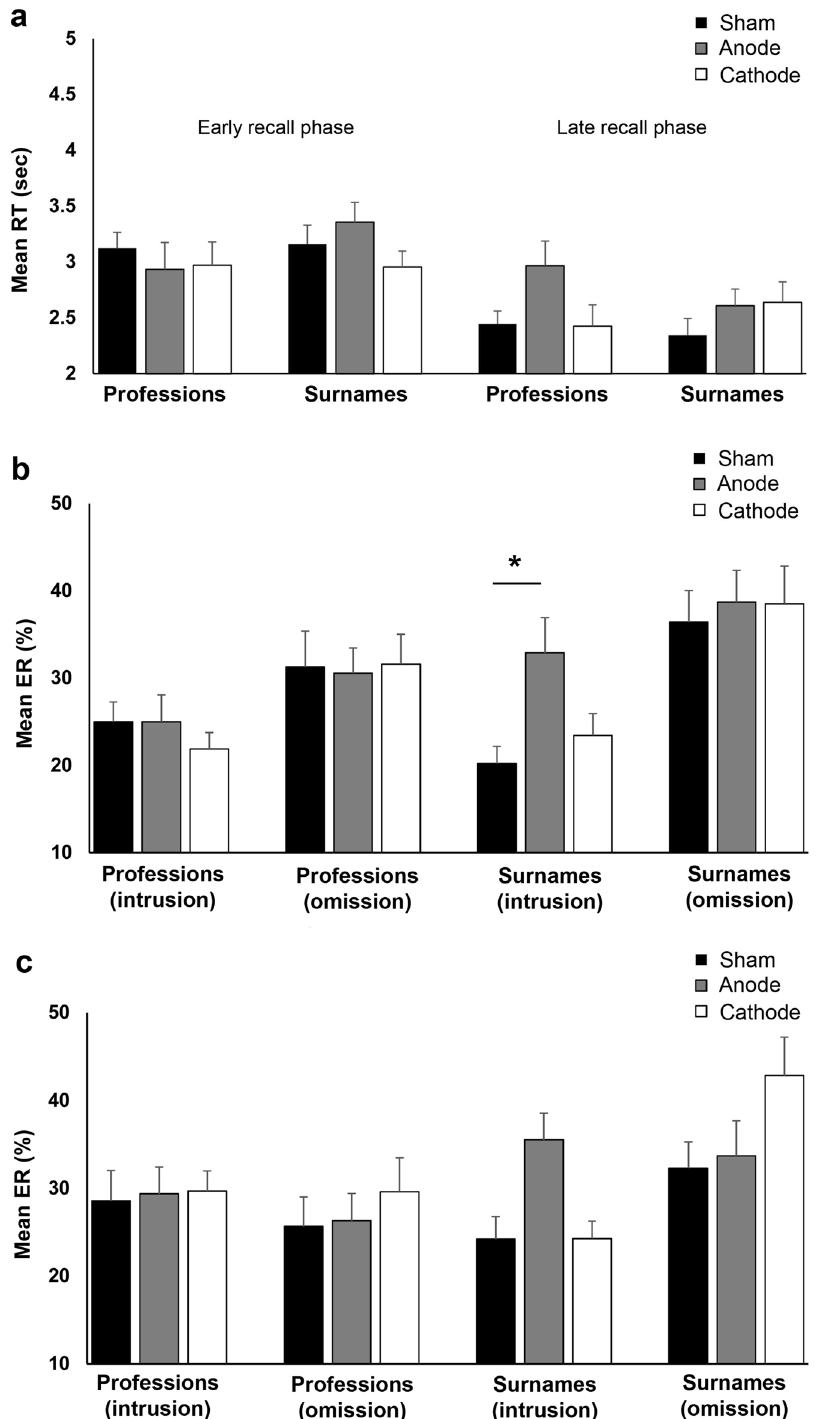
Figure 2. Effects of left ATL tDCS on the recall of person-specific information ( a ) Reaction times (RT) during the early and late recall phases. The x-axis displays the person-specific information and stimulation conditions in the early and late recall phases. The y-axis represents the mean RT (sec) for correct trials. Overall, RTs were significantly shorter for professions than surnames and the late recall phase than the early recall phase. ( b ) Early and ( c ) late recall phase’ error rates (ERs). The x-axis displays the person-specific information and error type per stimulation conditions. The y-axis represents the mean ERs (%). Overall, intrusions are significantly higher in the anodal condition compared to sham and cathodal conditions. *Indicates significant differences in ERs between stimulation conditions. Error bars represent the standard error of mean